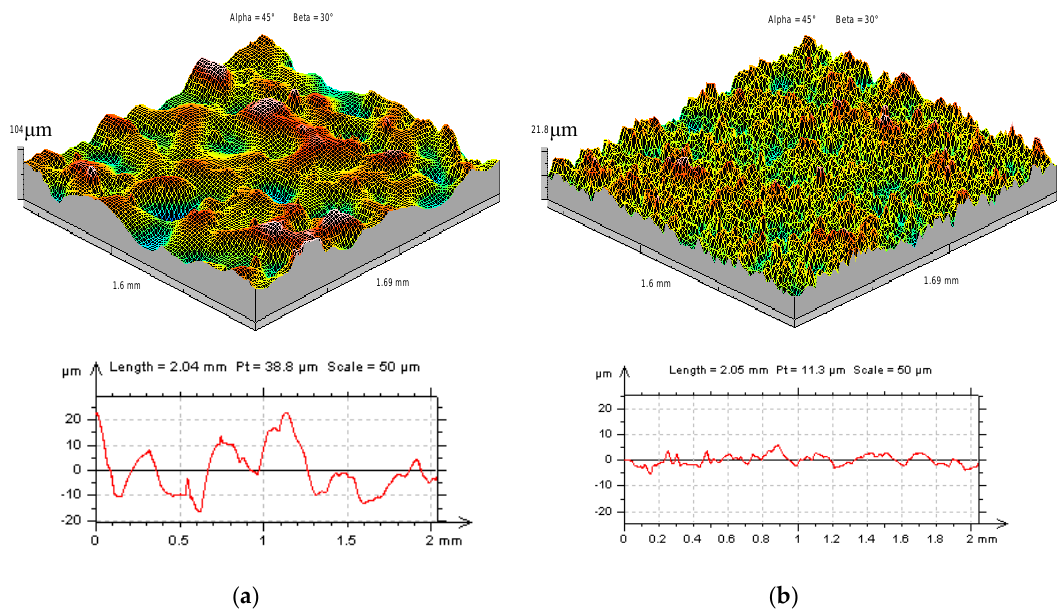
Figure 5. The surface texture of the tool steel 55NiCrMoV7 after electrical discharge machining (EDM): ( a ) U c = 25 V, I = 8.5 A, t on = 400 µs, t off = 150 µs; ( b ) U c = 25 V, I = 3 A, t on = 400 µs, t off = 80 µs.